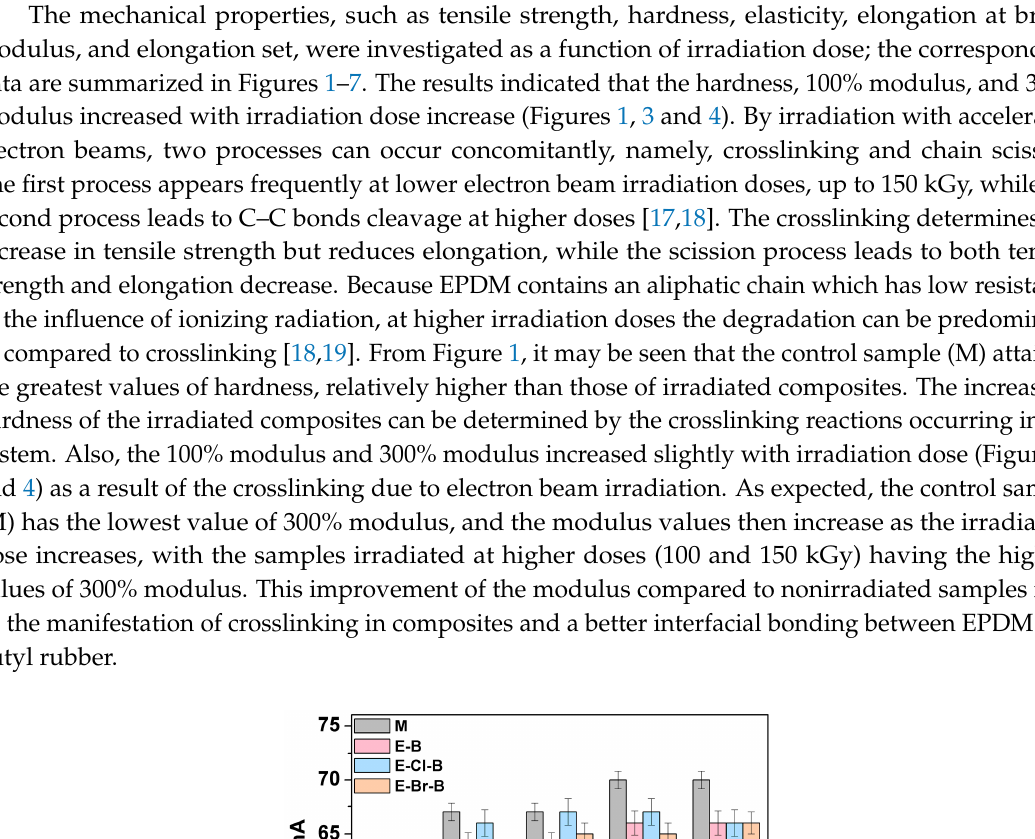
Figure 2. Elasticity of EPDM/butyl rubber composites as a function of irradiation dose.